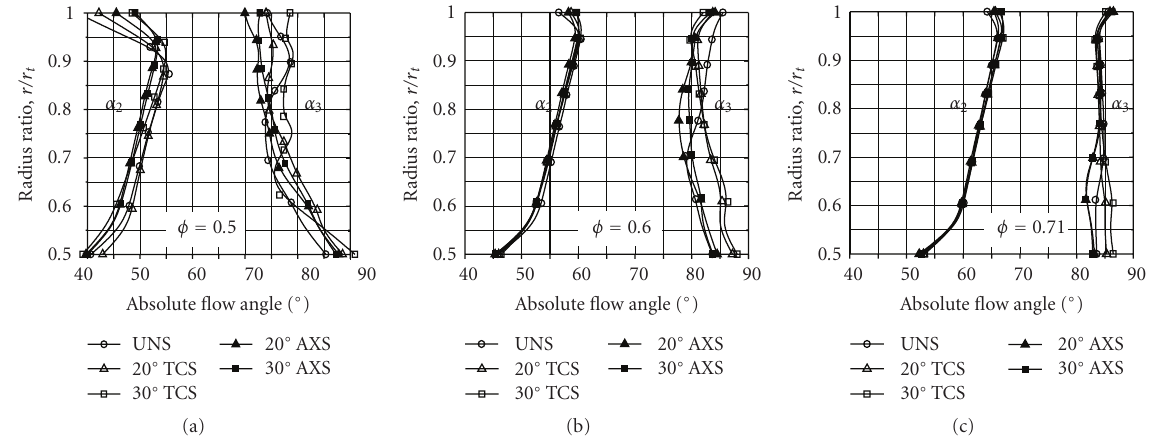
Figure 11: Spanwise variation of absolute Flow angle, α at rotor exit and stator exit.